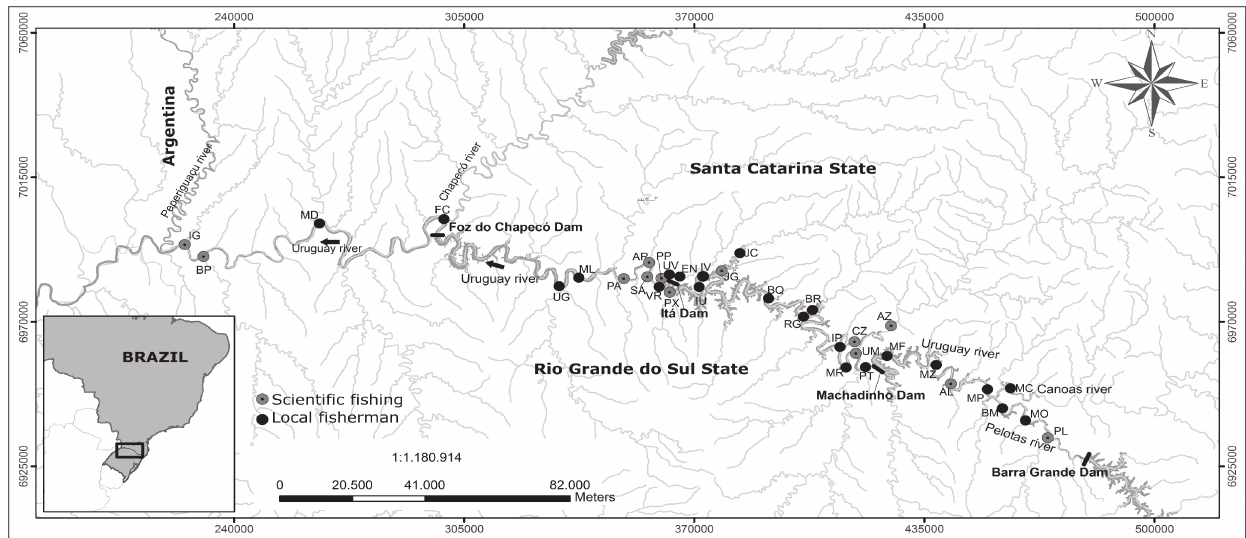
Fig. 2. Study area in the Upper Uruguay River Basin, border between Santa Catarina and Rio Grande do Sul States, Southern Brazil. The black (scientific fishing) and gray (fishermen fishing) dots indicate the sampling sites of Salminus brasiliensis